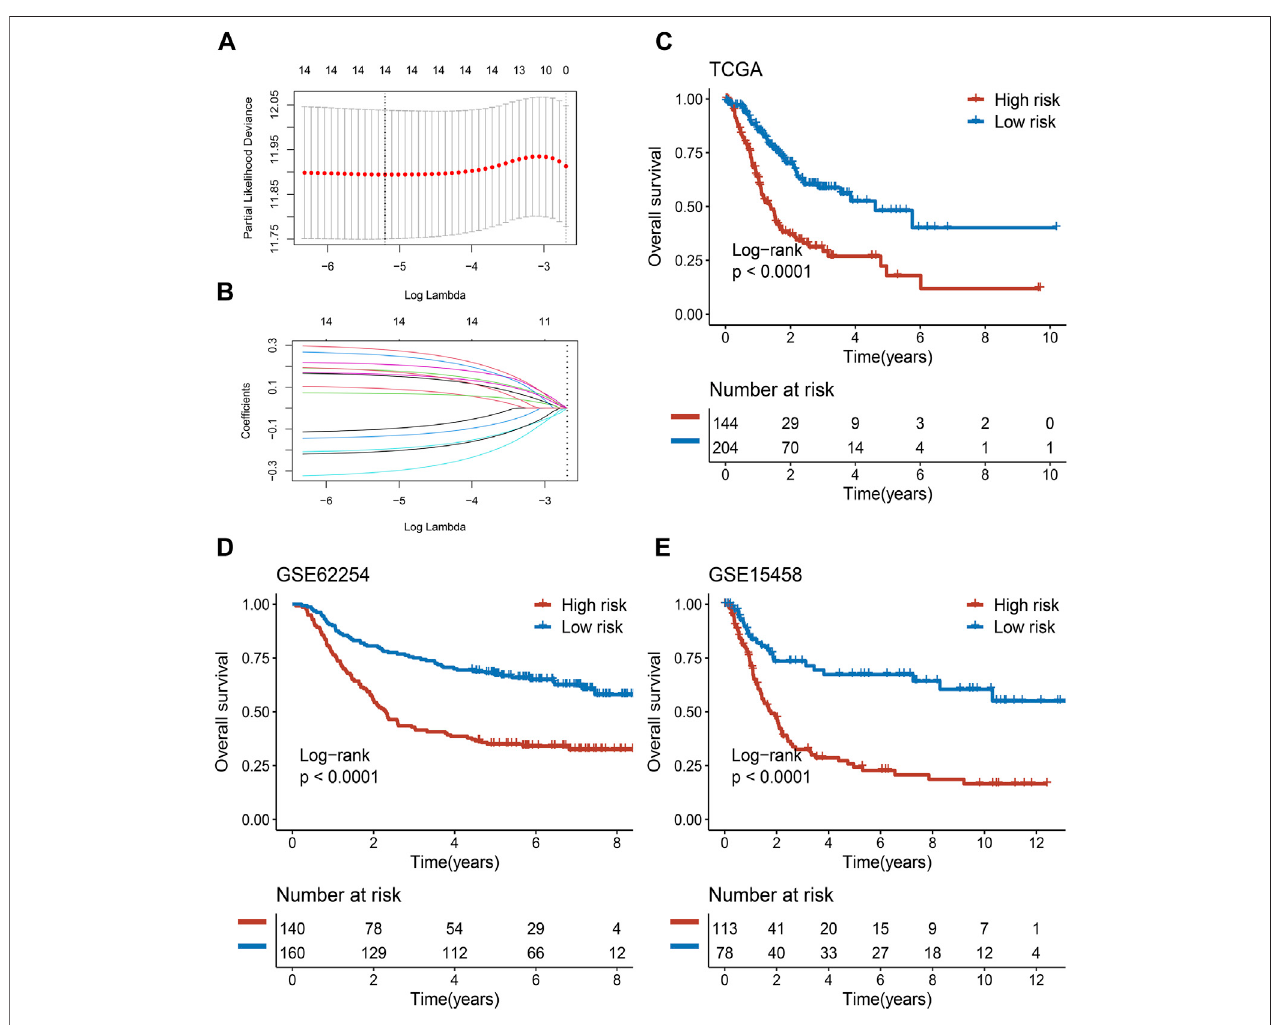
FIGURE2 | Development and validation ofthe PPSM model in clinicalsamples. (A,B) Least absolute shrinkage and selectionoperator (LASSO) logisticregression algorithmtoscreenofgenepairsassociatedwithprognostic. (C – E) Kaplan – MeiercurvesofOSaccordingtothehigh-andlow-riskgroupsinTCGA (C) ,GSE62254 (D) , and GSE15458 (E)